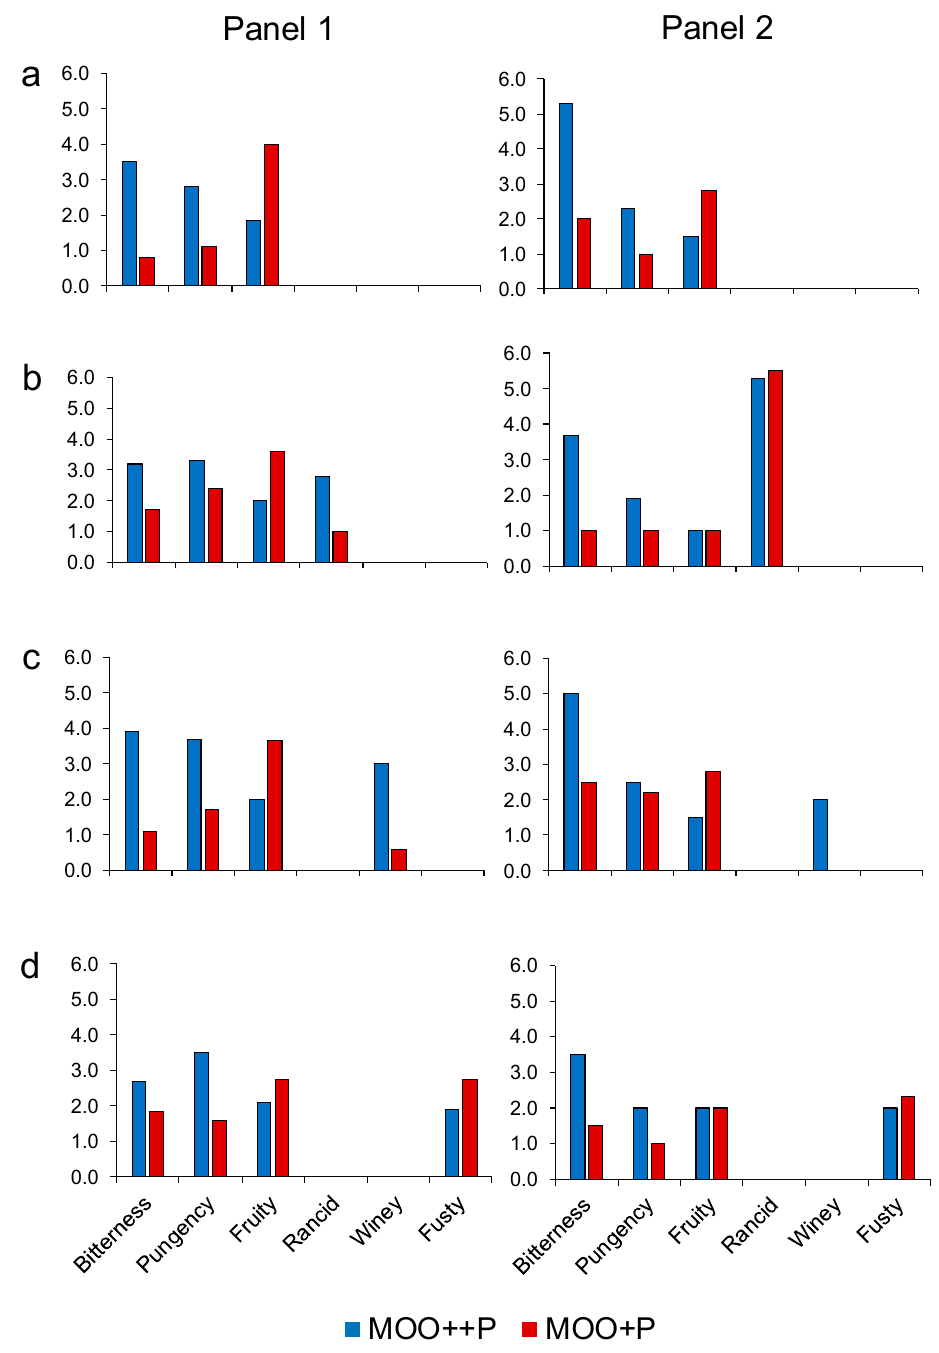
Figure 2. Sensory profiles of two panel tests obtained by analysing MOO+P in comparison to MOO++P samples without off-flavours ( a ) and with ‘rancid’ ( b ), ‘winey–vinegary’ ( c ) and ‘fusty–muddy’ ( d ) defects. MOO+P code indicates the lowest level of phenolic compounds in model olive oil while MOO++P is the highest level. Sensory attributes are expressed as median on an unstructured 0–10 scale.